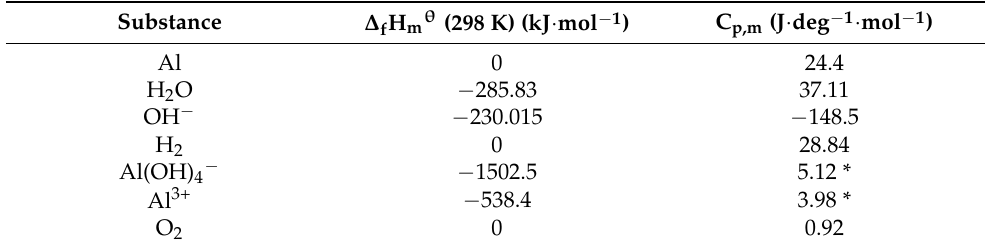
Table 1. Thermodynamic data for ∆ f H m θ (298 K) and ∆ C p,m (B) at 298.15 K.